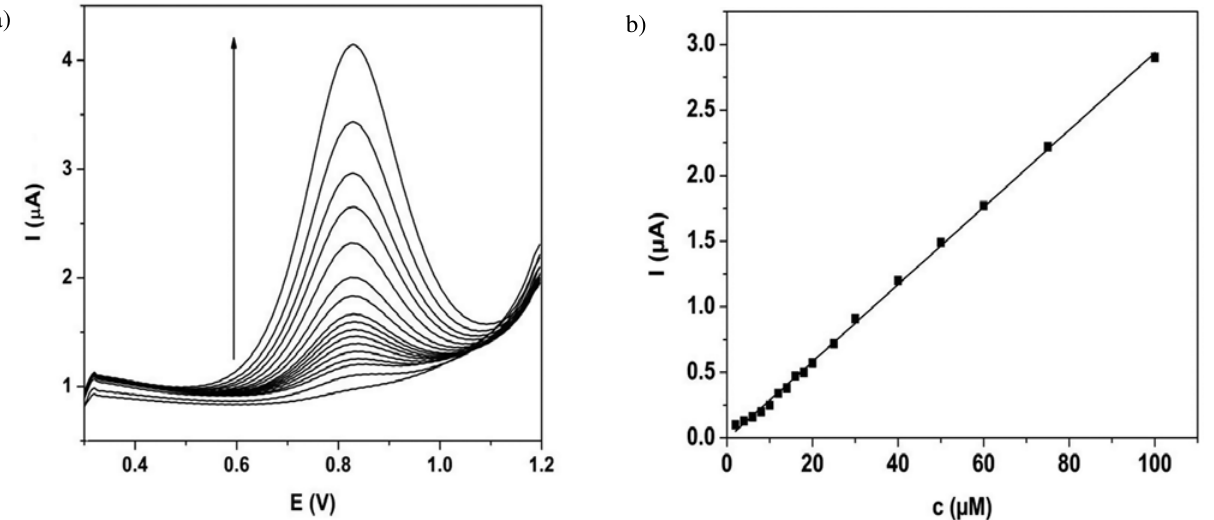
Figure 3. a) SW voltammograms of L-DOPA at a BDDE obtained for different concentrations (2 to 100 μM) under optimized experimental condi- tions. b) Calibration curve obtained from these